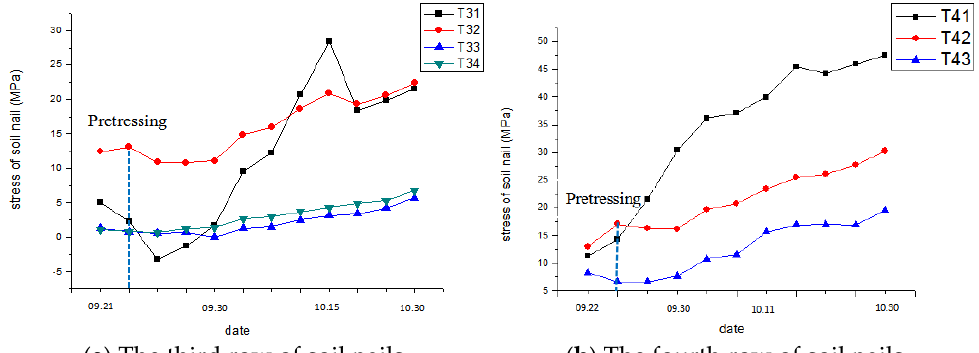
Figure 14. Stresses of the lower two rows for section No. 5.